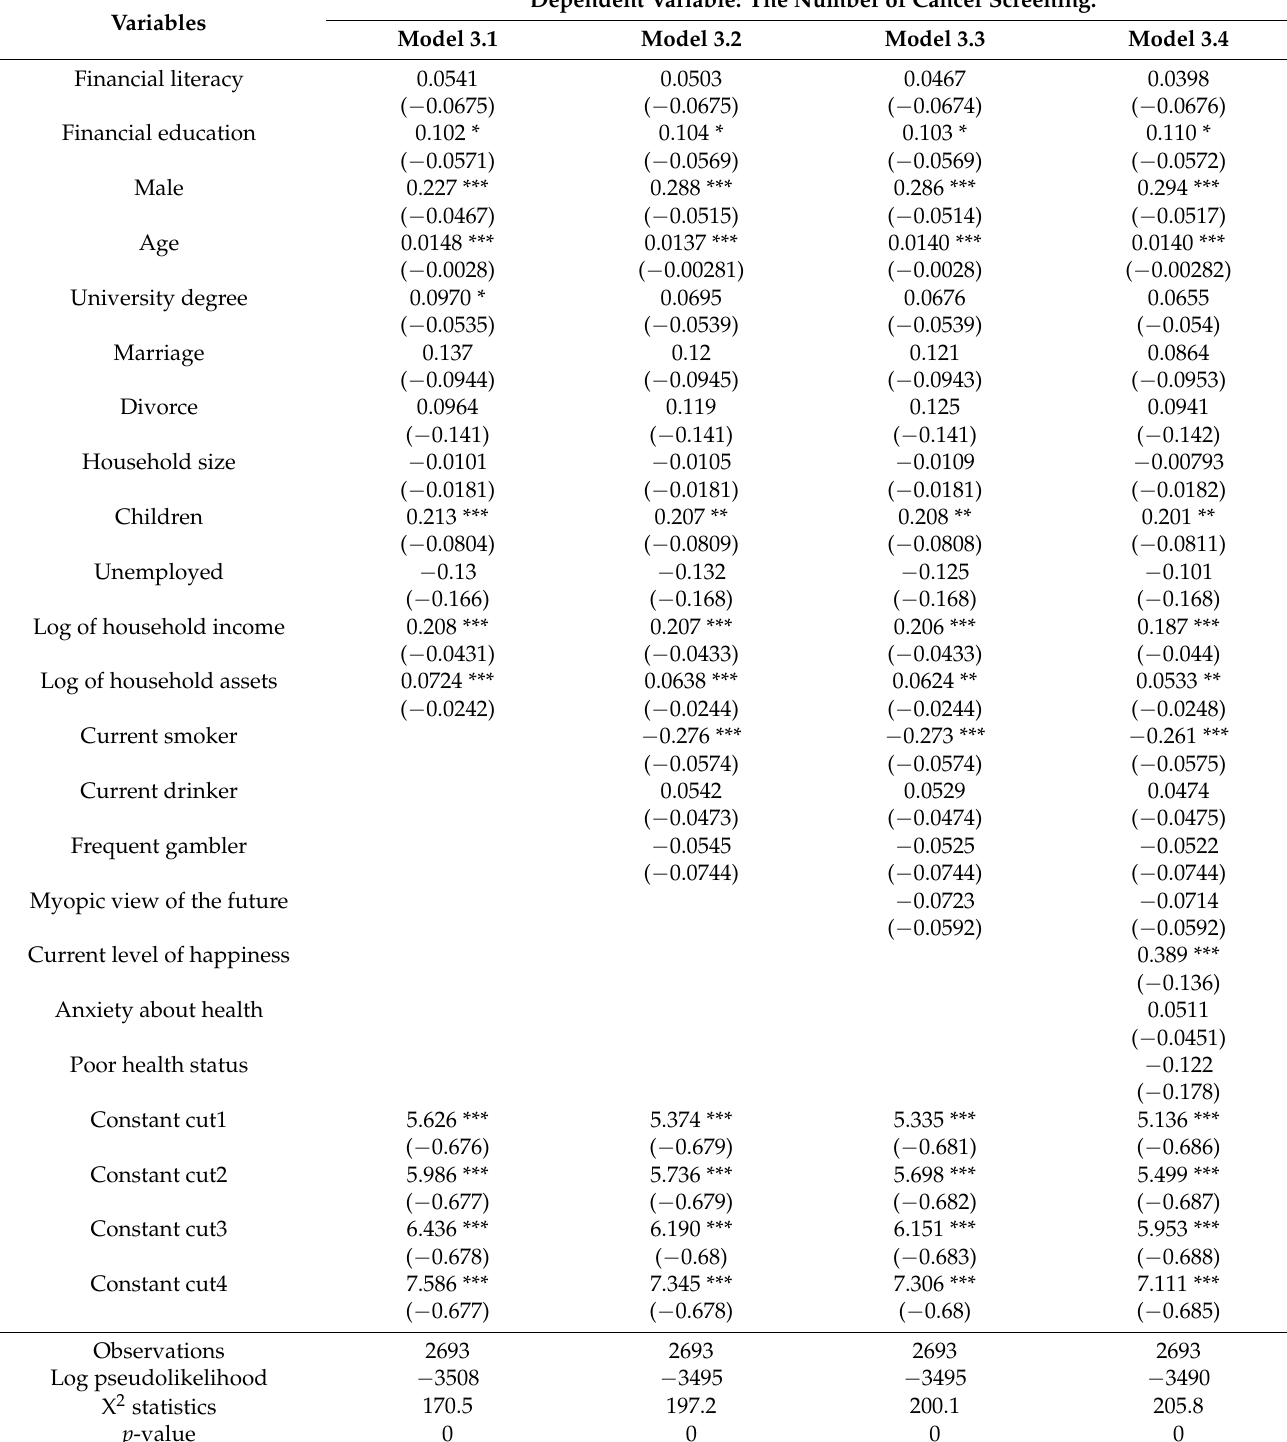
Table 8. Ordered probit model regression results with both financial literacy and financial education as the main explanatory